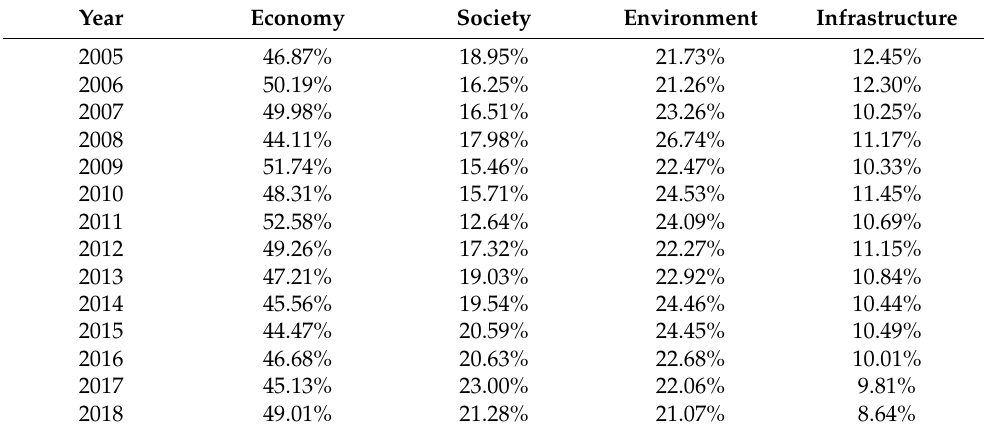
Table 5. The structural source contribution of the overall resilience difference among the eight urban